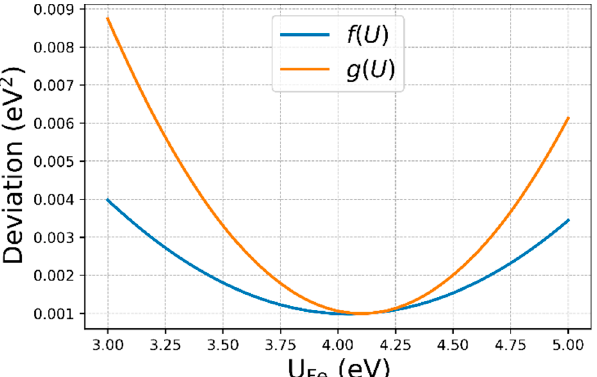
Figure A1. Deviation functions of formation energy differences between the calculated and experimental values from the linear fit ( 𝑓(𝑈) ) and of calculated oxidation energies from the corresponding experimental values ( 𝑔(𝑈) ).